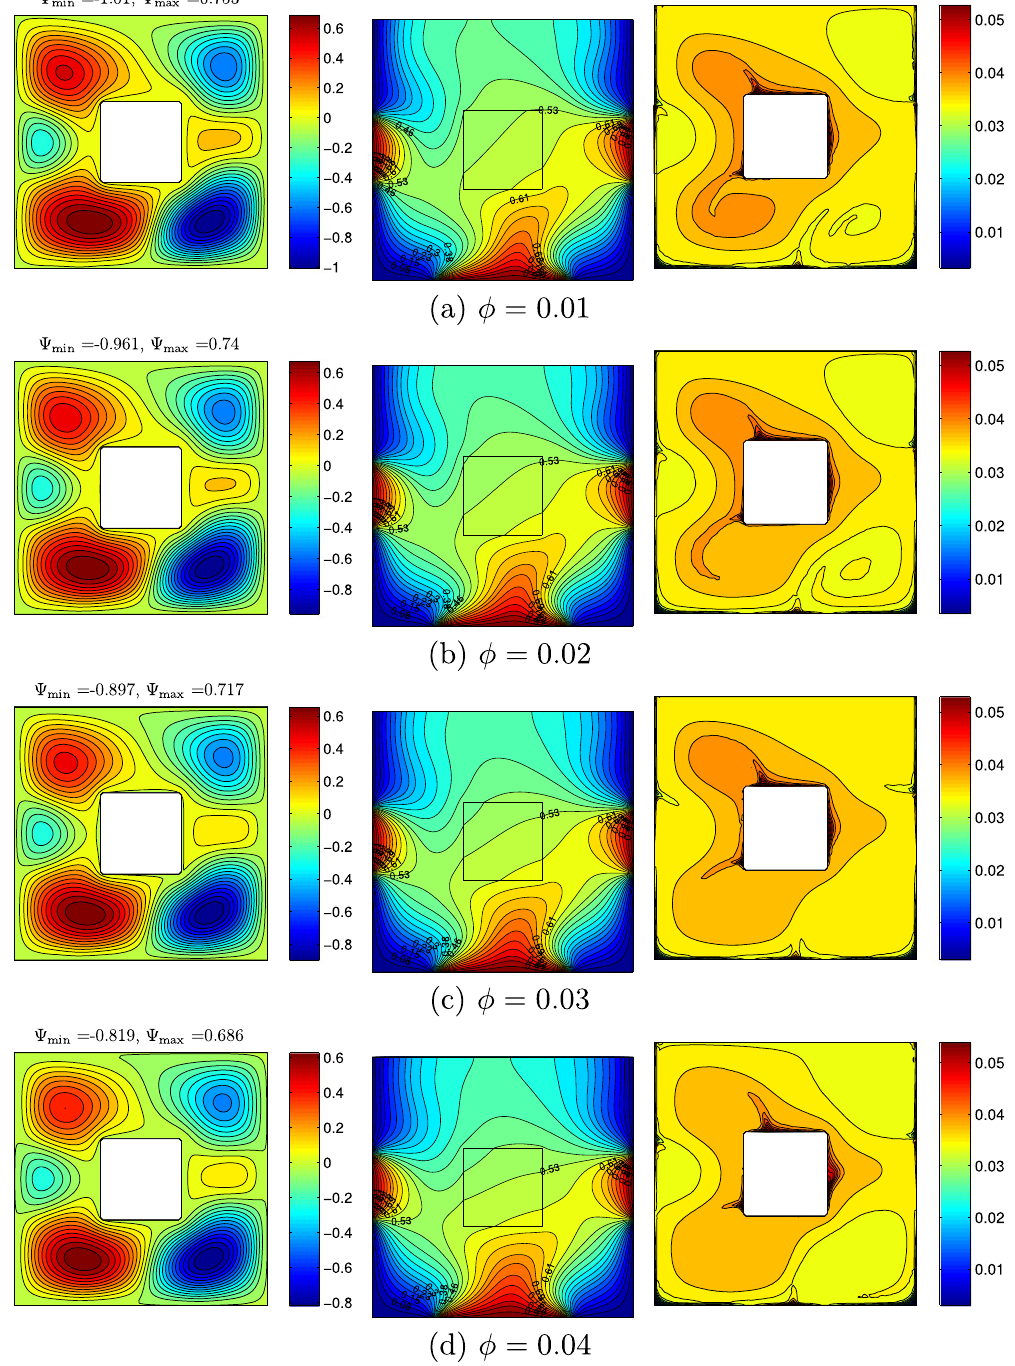
Figure 10. Variation of the streamlines (left), isotherms (middle), and nanoparticle distribution (right) evolution by nanoparticles volume fraction ( φ ) for Ra = 10 5 , Ha = 15, K w = 0.76 and D =